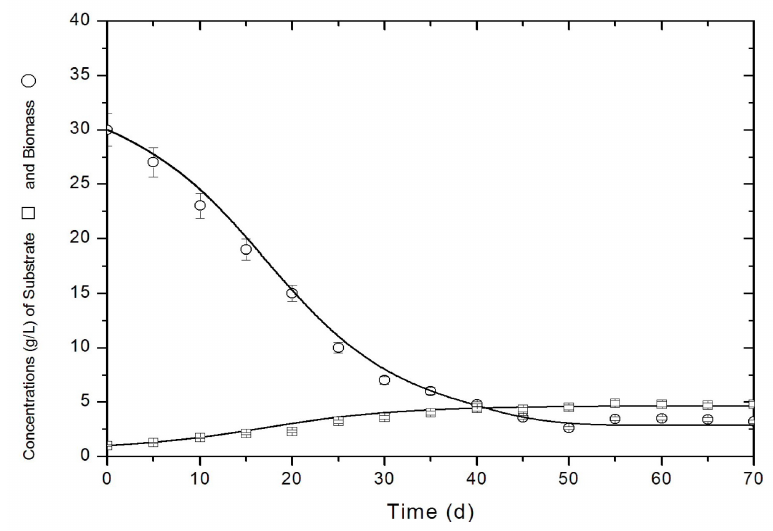
Figure 1. Real data (symbol) and predicted dynamics (continuous line) of substrate-biomass.